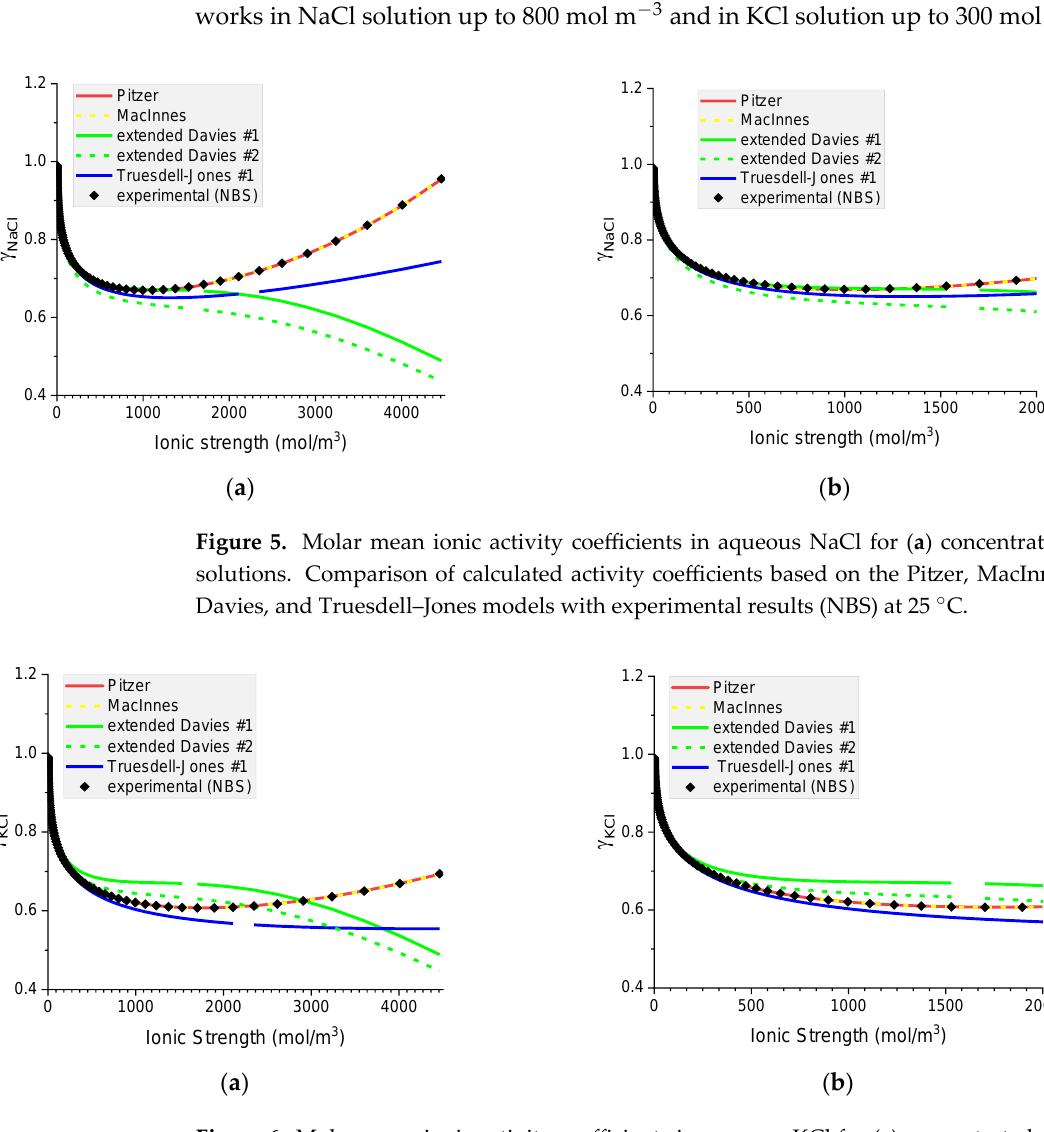
Figure 6. Molar mean ionic activity coefficients in aqueous KCl for ( a ) concentrated and ( b ) dilute solutions. Comparison of calculated activity coefficients based on the Pitzer, MacInnes, extended Davies, and Truesdell – Jones models with experimental results (NBS) at 25 °C.